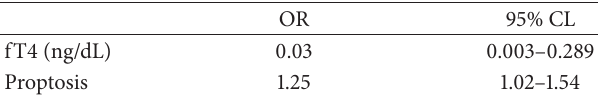
Table 3: Outcomes of binary logistic regression analysis.